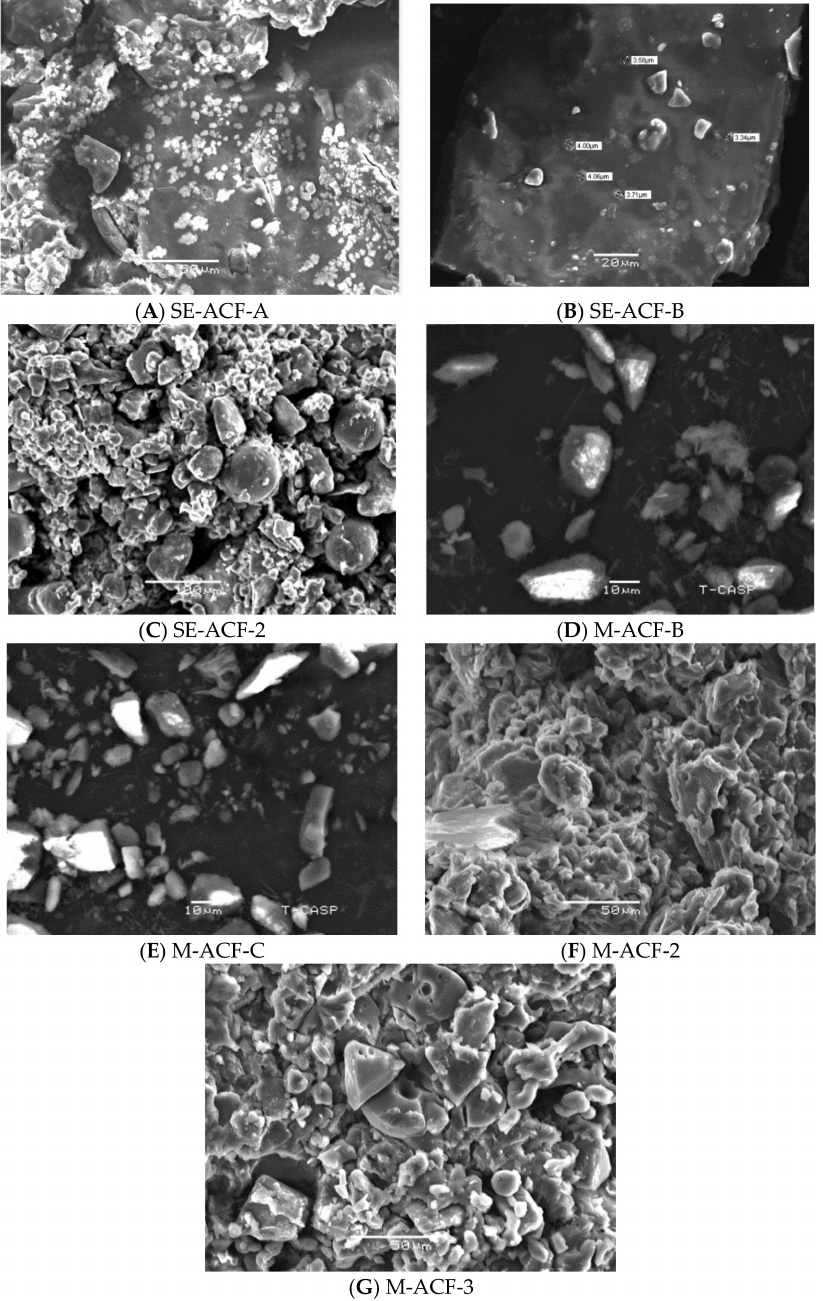
Figure 5. SEM of ACF solid dispersions prepared by solvent evaporation with ratios ( A ) 1:1, ( B ) 1:2 and ( C ) 1:2, and prepared by melt methods with ratios ( D ) 1:2, ( E ) 1:3, ( F ) 1:2, and ( G )